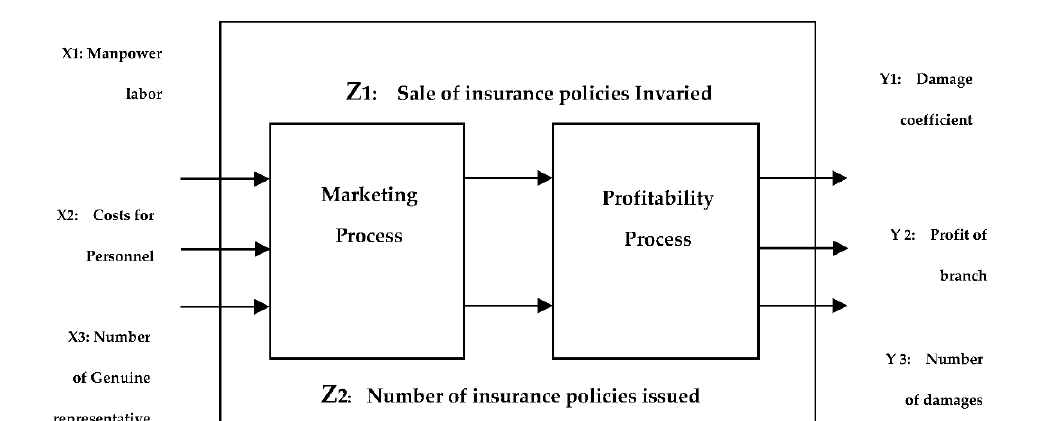
Figure 4. Procedure of proposed method.